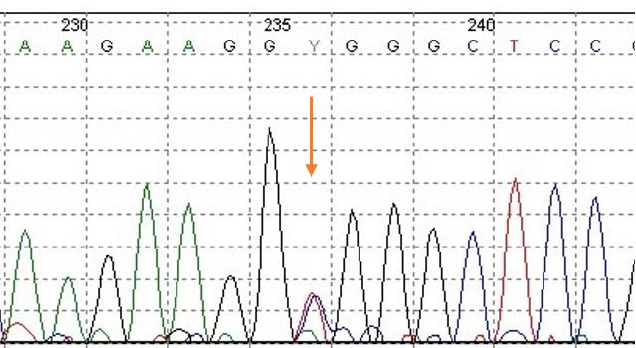
Figure 4. Expected CYP11A1 : c.1236 + 5G > A mutation effect on splicing. ( A ) Splicing mutation within the canonical splice sites leading to whole exon skipping; ( B ) splicing mutation resulting in the usage of the cryptic exonic or intronic splice site that leads to the inclusion of an intron fragment or exon fragment skipping.